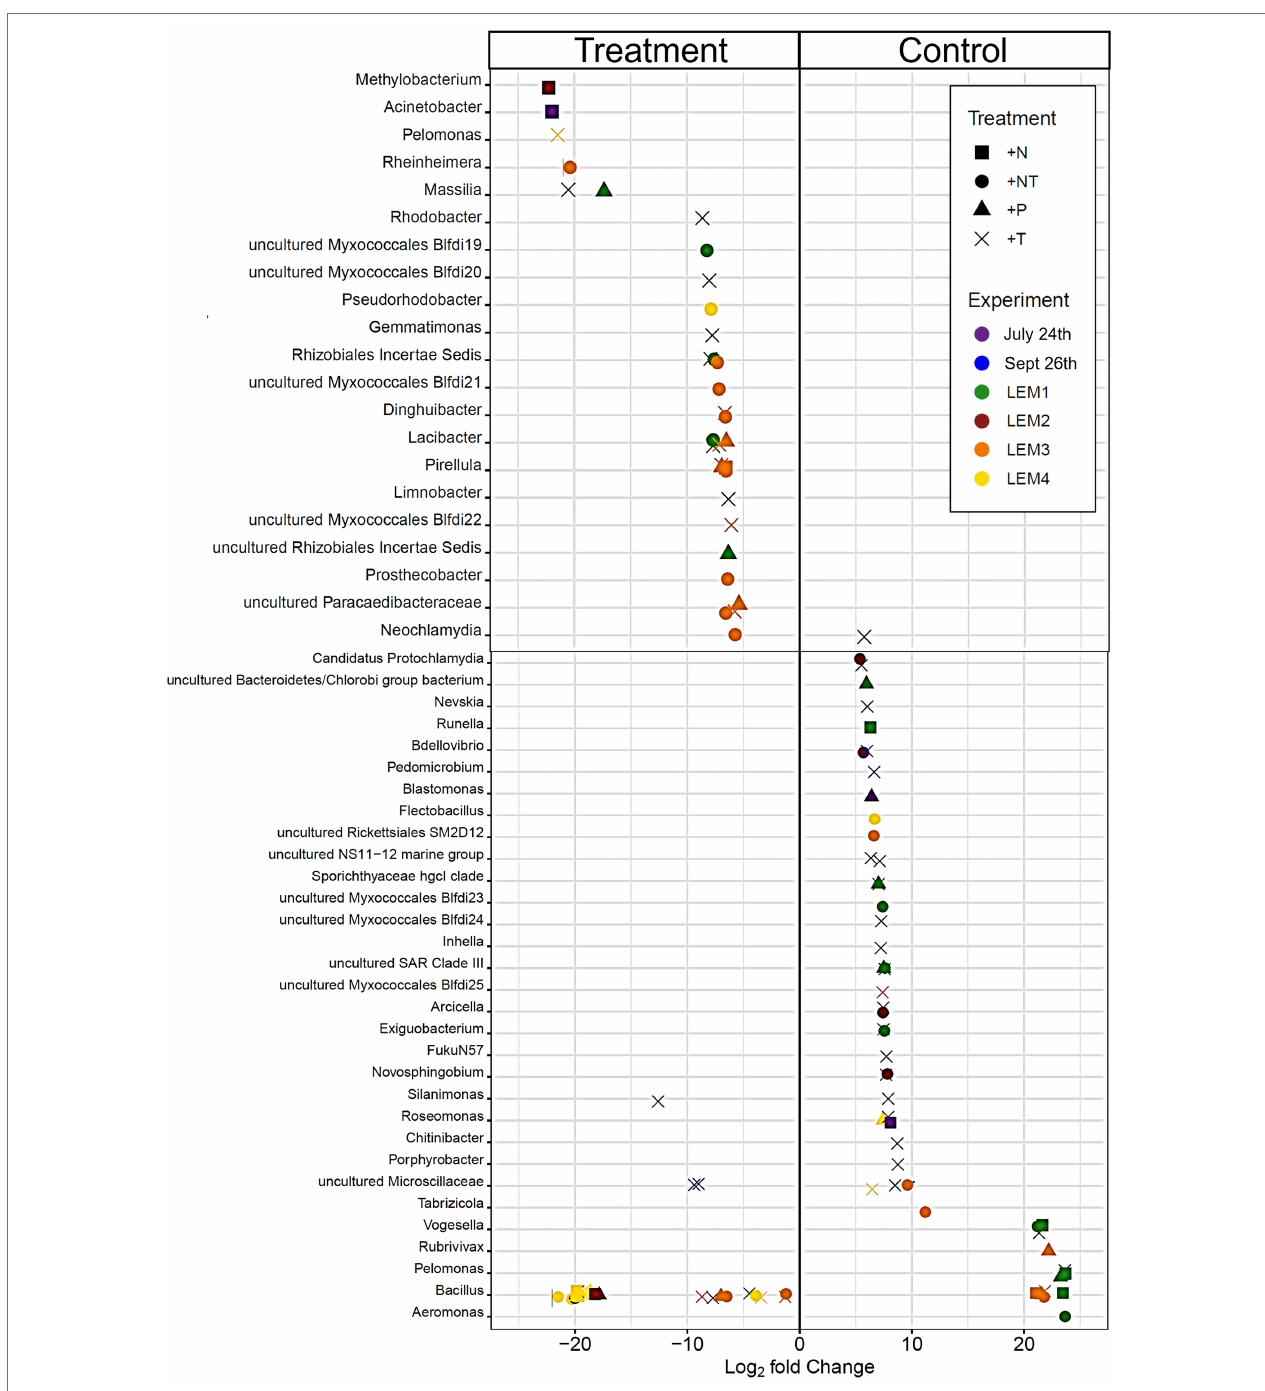
FIGURE 4 | Bacterial ASV’s found to be significantly differentially abundant between the control and treatments among the experiments ordered by degree of fold change. Points with positive log fold changes are significantly enriched in the control, points with negative log fold changes are significantly enriched in the treatment. Only ASV’s with a log 2-fold change greater than 5 are